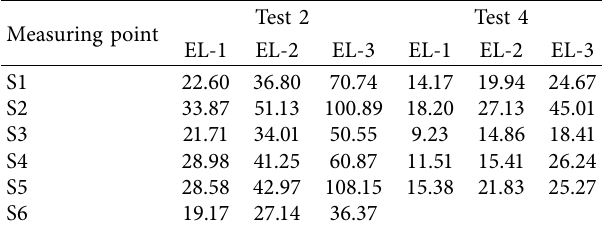
Table 7: Strain peak of structure under EL wave ( με ). Measuring